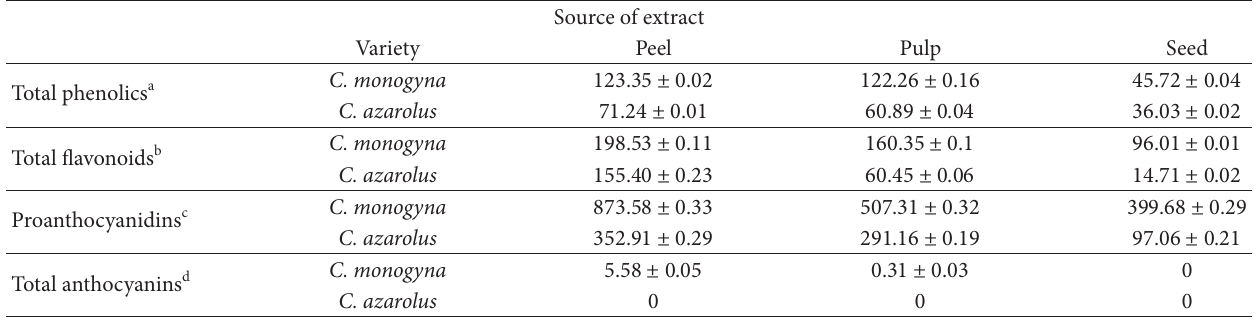
Table 1: Phenolics contents in different crude part extracts of red and yellow Crataegus.